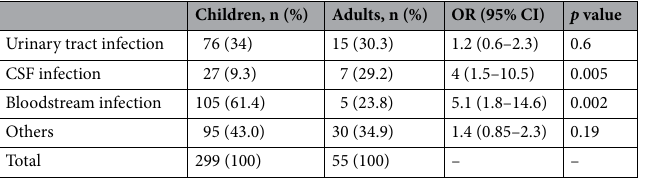
Table 2. Distribution of isolates from various infections in children and adult patients.